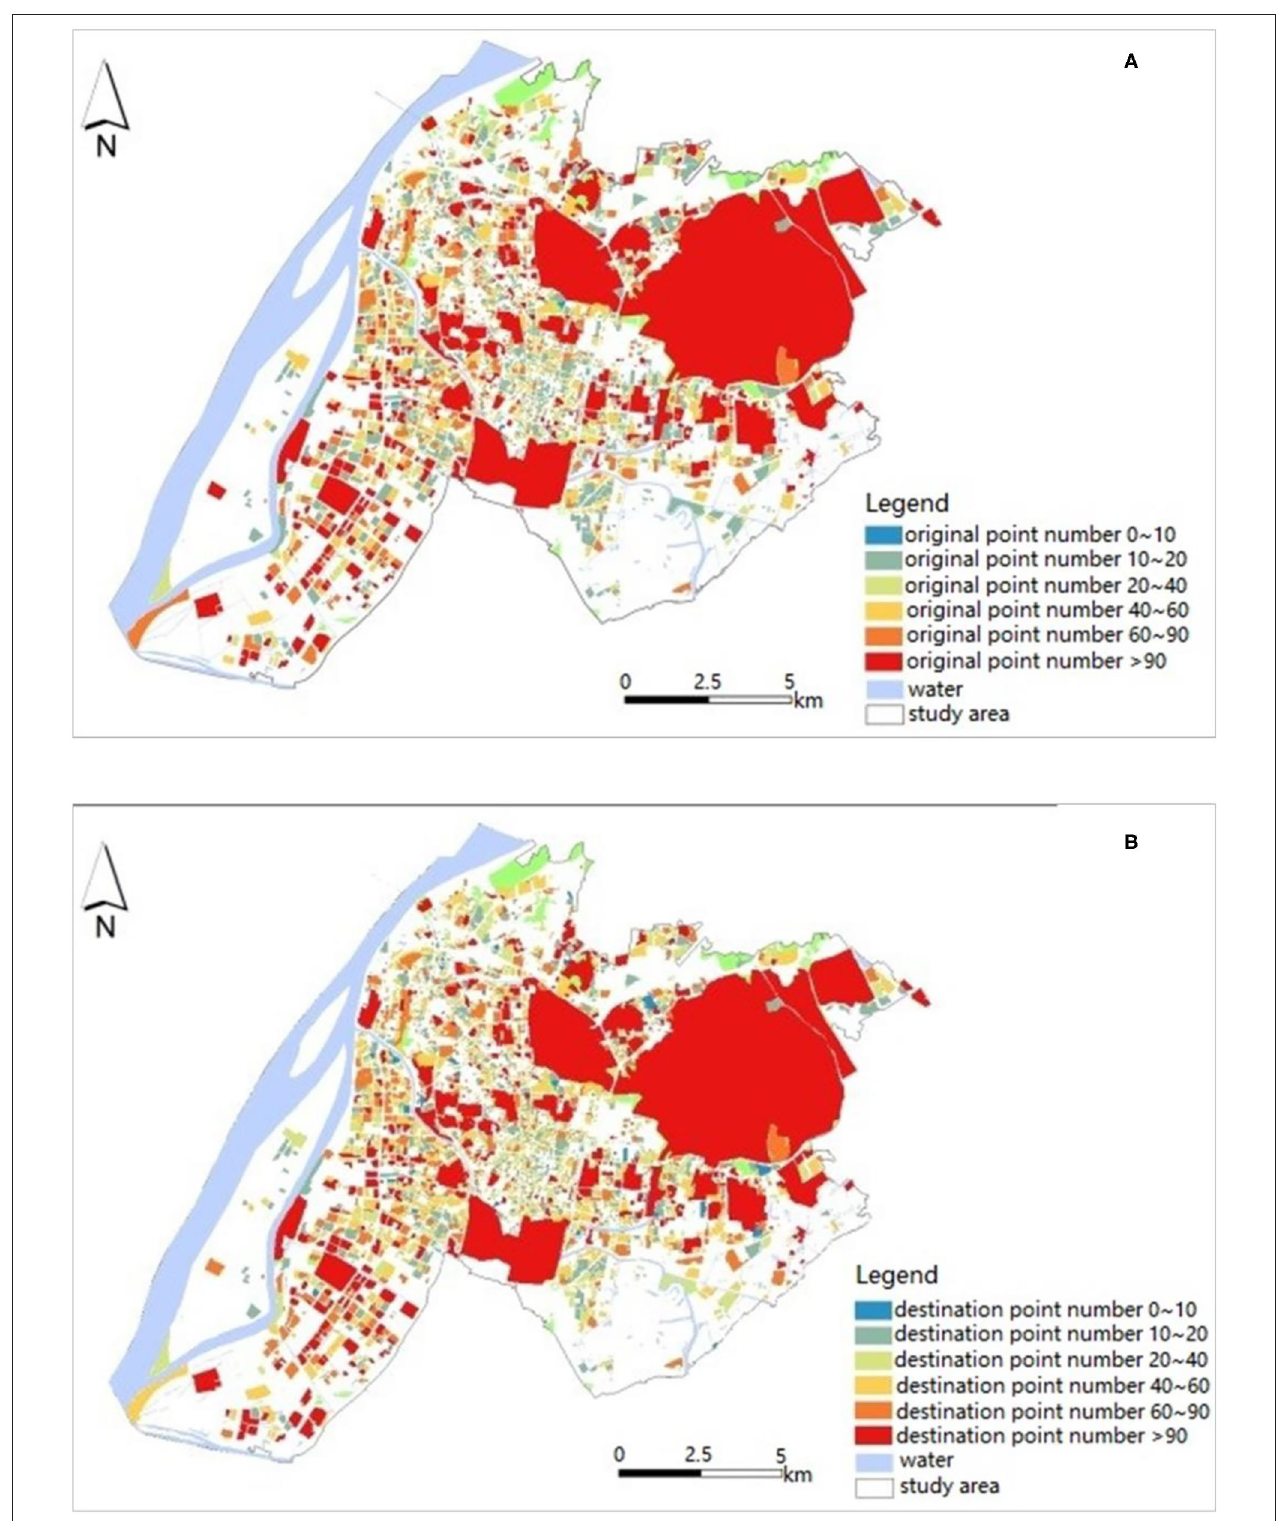
FIGURE 6 | Prediction results at 8 am of study area. (A) Origin points. (B) Destination points.